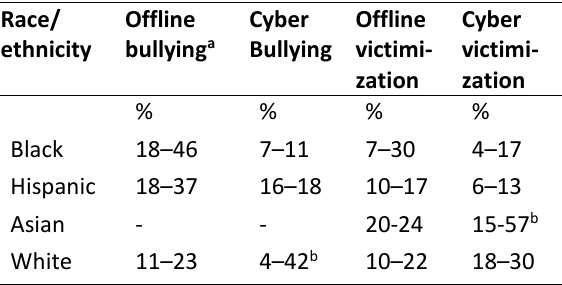
Table 1. Rates of offline bullying and cyberbullying par- ticipation for youth of